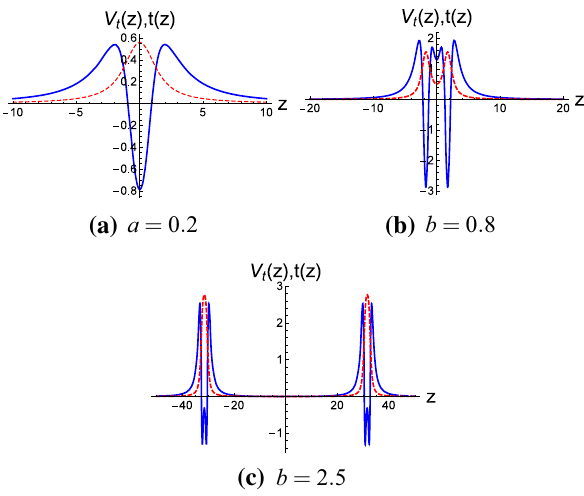
Fig. 4 a b = 0 . 5, b b = 3, c b = 8. The effective potential V t ( z ) (blue solid lines) and the zero mode t 0 ( z ) (red dashed lines) of the tensor perturbation for brane model 2. The parameters are set k = 1, and b = 0 . 5 in a , b = 3 in b , b = 8 in c